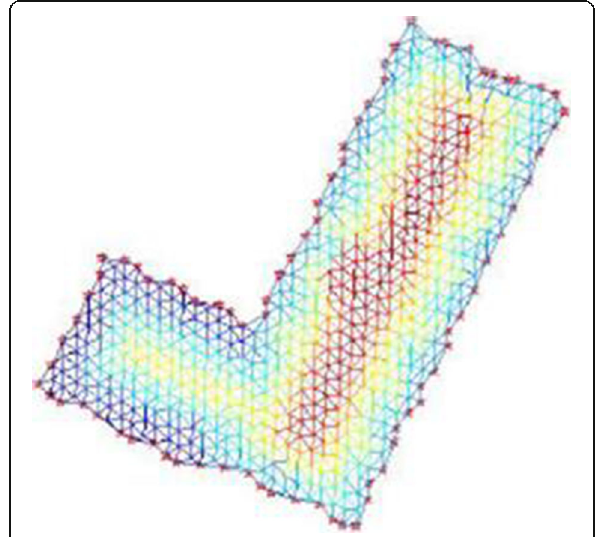
Fig. 7 The turning point of the